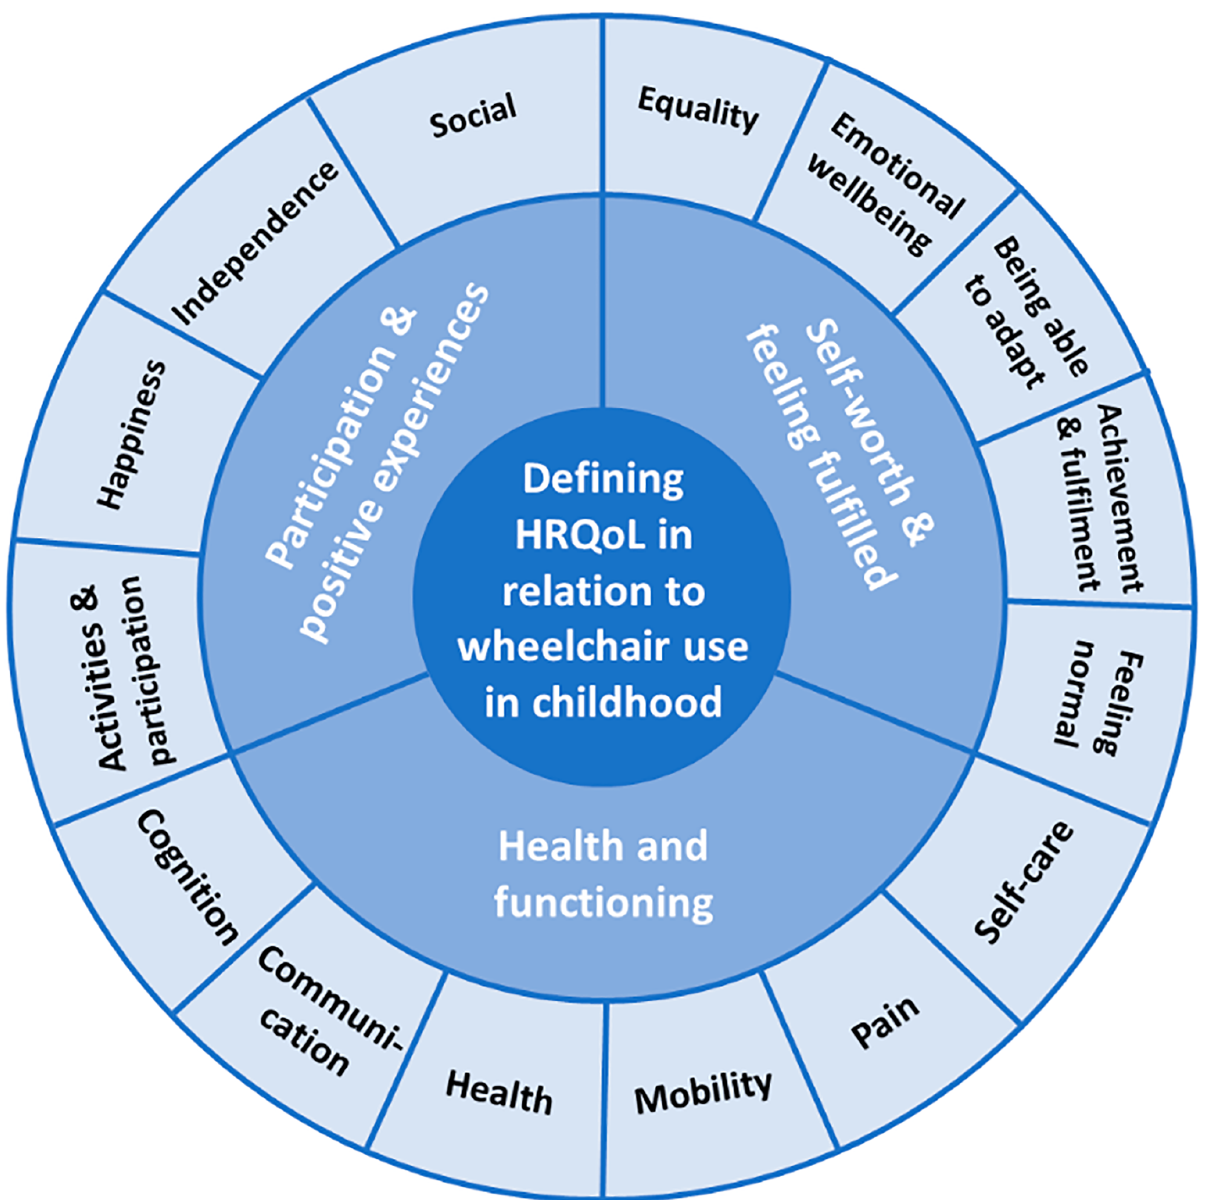
Fig 1. Defining mobility-related QoL in childhood. A thematic summary and map of mobility-related QoL domainsfor childrenand young